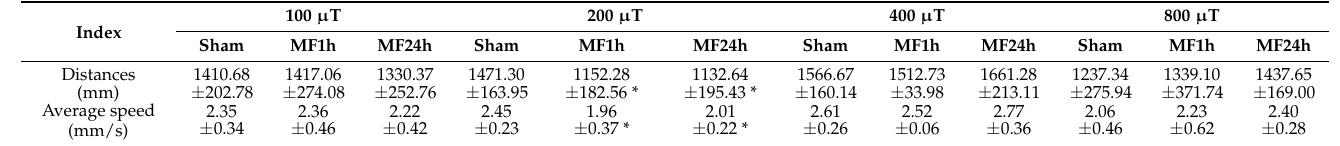
Figure 1. Effects of 50-Hz MF exposure on locomotor activity in zebrafish embryos/larvae. ( A ) MF exposure did not affect SM (spontaneous tail coiling) at 24 hpf within 1 min; ( B ) Exposure to MF with 200 µ T decreased movement distance and average speed of SM at 120 hpf within 10 min; ( C ) MF exposure did not affect locomotor response to light-dark transition at 120 hpf. * p < 0.05, compared with sham. Table 2. The spontaneous movement of 50-Hz MF exposure on zebrafish ( M ± SD ).